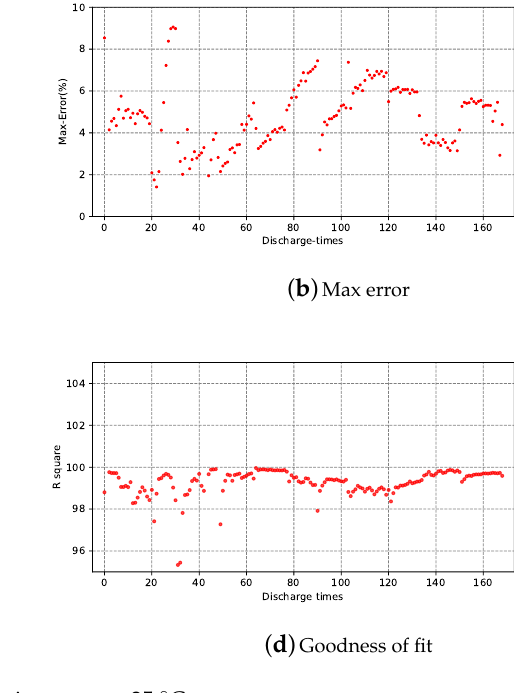
Figure 13. Estimation error at 25 ◦